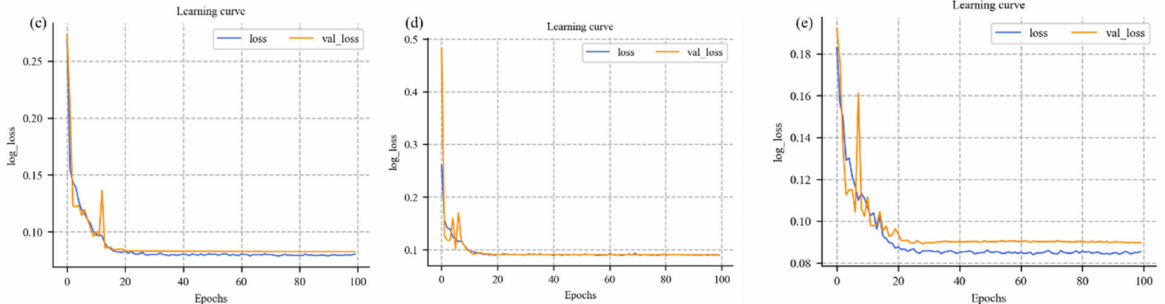
Figure 7. Learning curve of network training with different modules: ( a ) the learning curve of U-Net, ( b ) the learning curve of U_Net_D, ( c ) the learning curve of U_Net_A, ( d ) the learning curve of U_Net_A_D, and ( e ) the learning curve of U_Net_A_D_AS.